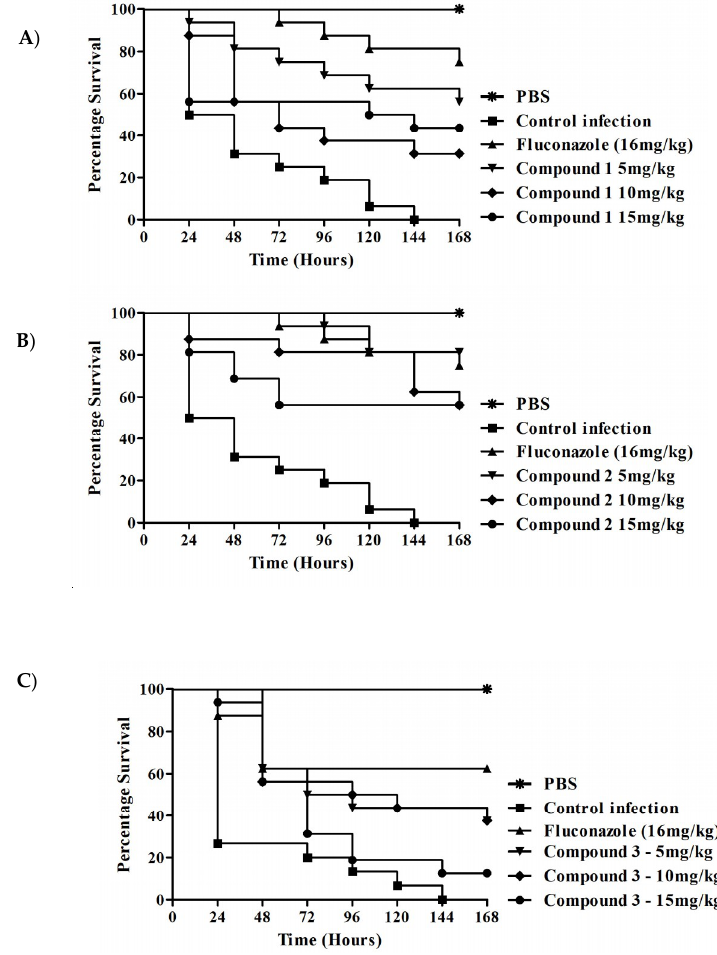
Figure 4. Toxicity of thiazolylhydrazone in Galleria mellonella. Larvae were injected with the thiazolylhydrazone compounds 1 , 2 , 3 and 4 at a concentration of 10 mg/kg and their survival was evaluated till 144 h post-treatment. The larvae survival was 100% with the compounds 1 and 2 and 95% with the compounds 3 and 4 .